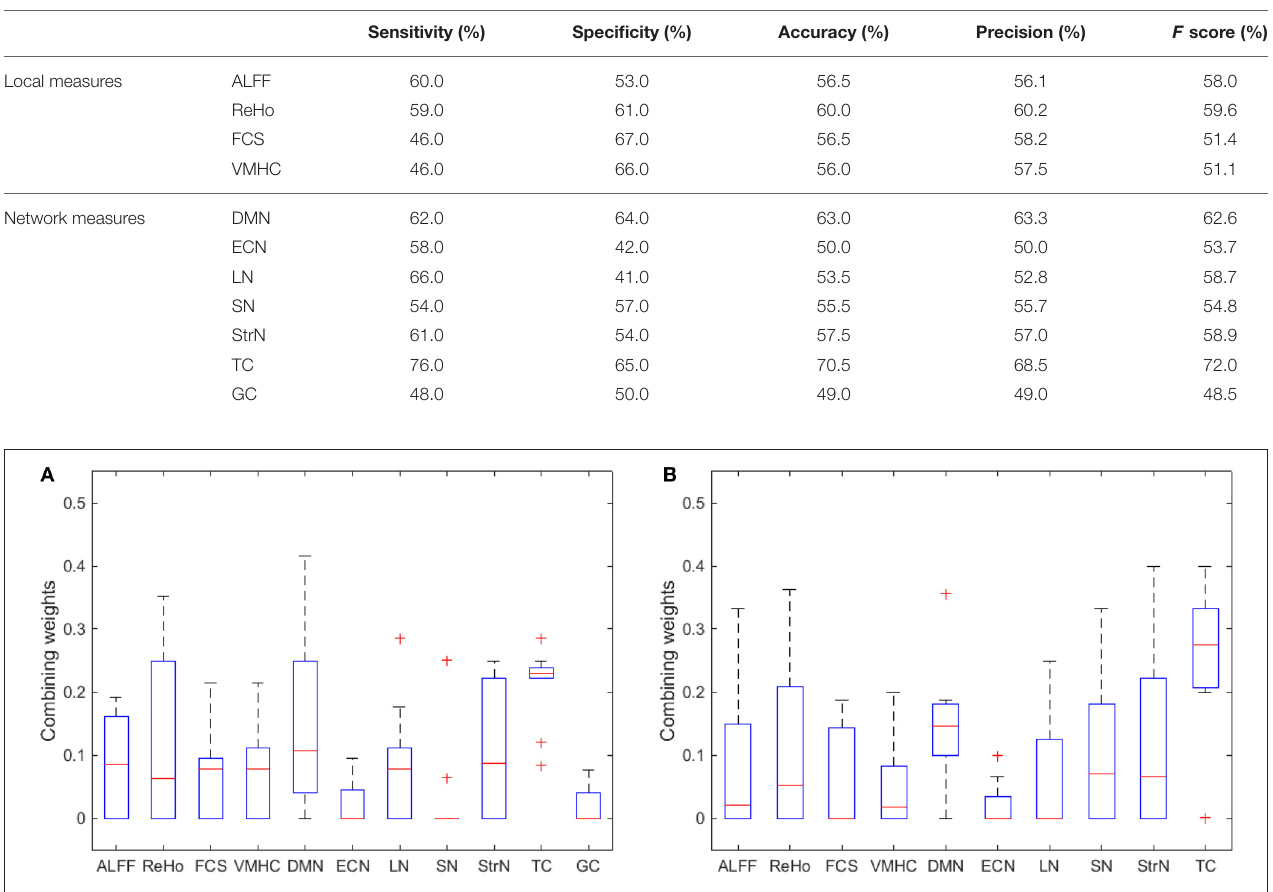
TABLE 4 | Discriminative ability of individual feature